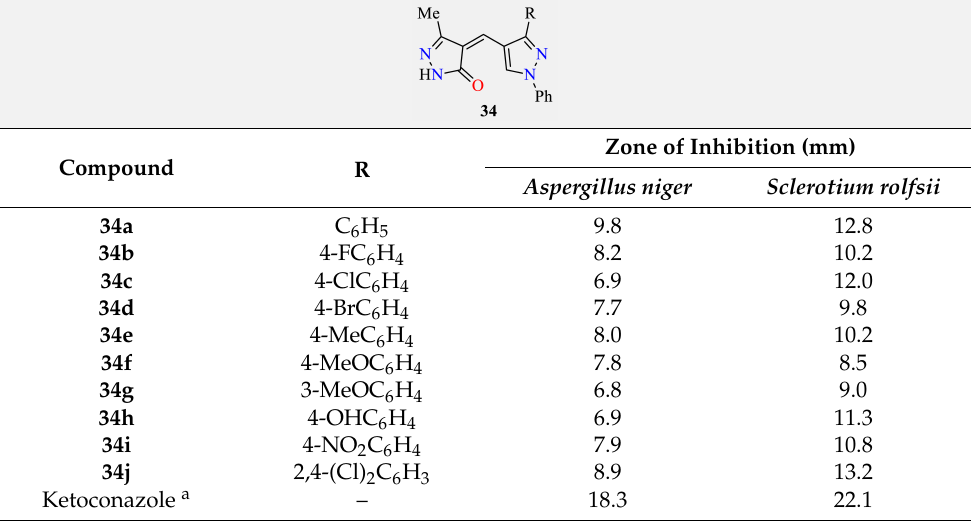
Table 42. Antifungal activity of 4-[(3-aryl-1-phenyl-1 H -pyrazol-4-yl)methylidene]-2,4-dihydro-3 H- pyrazol-3-ones 34 .